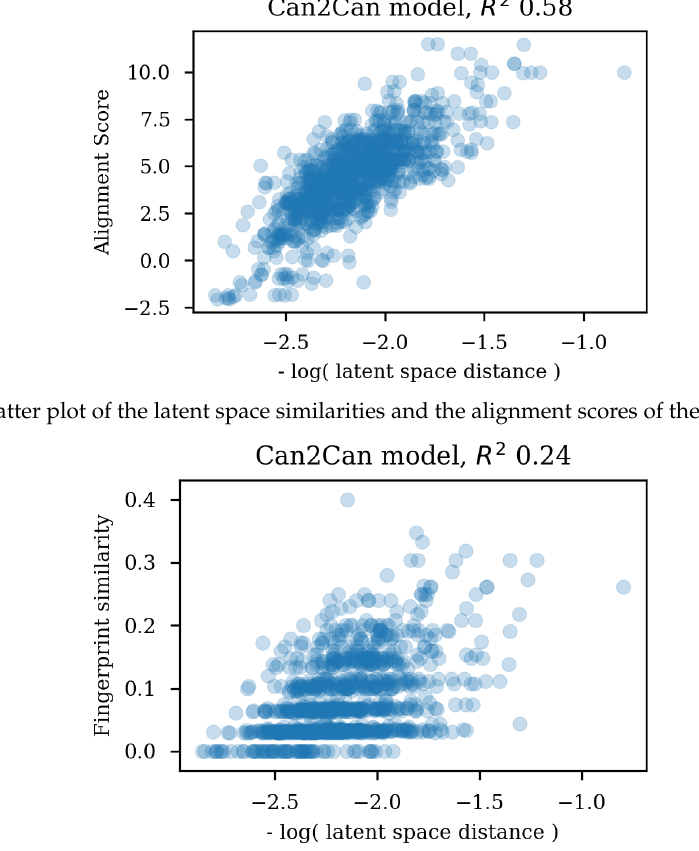
Figure 5. Scatter plot of the latent space similarities and the circular fingerprint